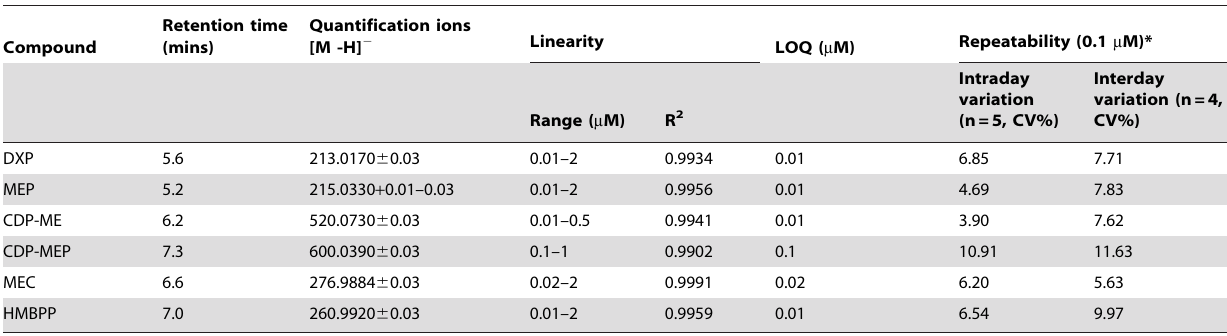
Table 1. Analytical performance of the SPE UPLC-MS method.